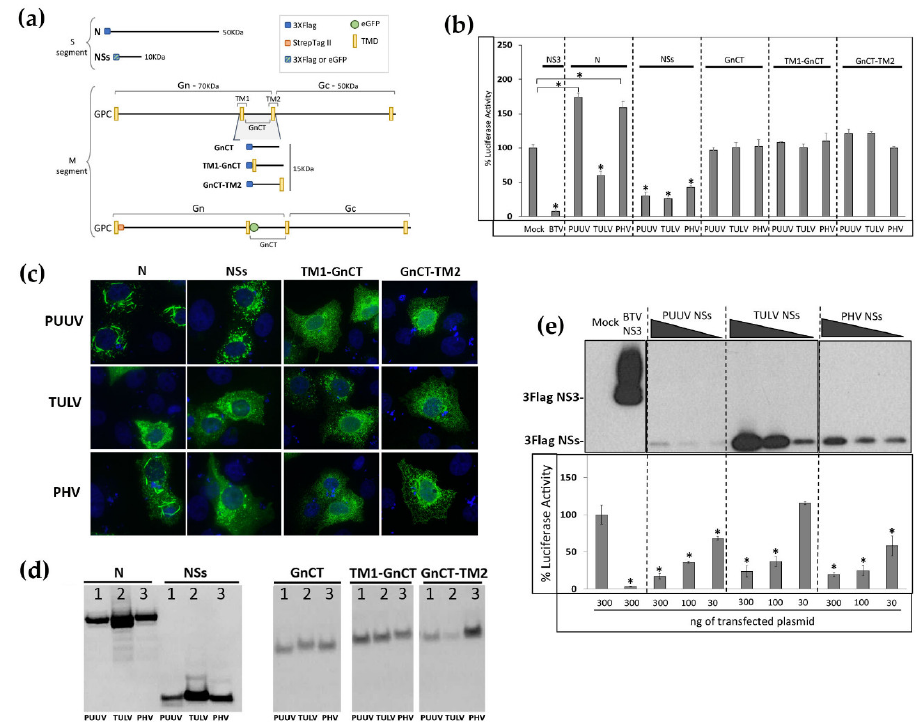
Figure 1. Effect of different hantaviral proteins on RIG-I-induced interferon promoter activity. ( a ) Schematic representation of the different tagged sequences used in our study: 3xFlag-tag (blue square), StrepTagII (orange square), and eGFP tag (green circle) were added to N, nonstructural (NSs) or the different forms of GnCT (GnCT, TM1-GnCT, GnCT-TM2) of pathogenic Puumala virus (PUUV), low-pathogenic Tula (TULV), and non-pathogenic Prospect Hill (PHV). In the case of full-length glycoprotein precursor (GPC), StrepTagII was added in N-ter and eGFP between the TM1 and cytosolic domains of Gn. ( b ) HEK293T cells were transfected with 300 ng of plasmids encoding N, NSs or GnCT variants of PUUV, TULV or PHV, together with the plasmid mix to express RIG-I, along with the IFN β -Luc and CMV-RL reporter genes. The histogram represents the percentage of luciferase activity 24 h post transfection using mock condition as 100% of IFN β -Luc activity induced by RIG-I and NS3 of BTV as control of inhibition. ( c ) Immunofluorescence staining of the different 3xFlag-tagged viral proteins was performed in VeroE6 cells, 24 h post-transfection, using an anti–Flag mAb then an anti-mouse IgG coupled to Alexa-488. The images obtained using an objective x63 are at the same magnification ( d ) Protein expression levels of N, NSs, TM1-GnCT, and GnCT-TM2 was controlled by western blot staining with anti-Flag-HRP mAb using 5 µ g of lysates from transfected HEK293T. In ( e ), the inhibitory effect of different amount of NSs proteins was tested on RIG-I-induced IFN β promoter-driven Luc activity (lower panel) and protein expression in the corresponding cell lysates was tested by western blot (upper panel). The results in ( b , e ) were obtained from technical triplicates of at least three independent experiments. The error bars correspond to standard deviation to the mean. Statistically representative differences are indicated: * = p value <